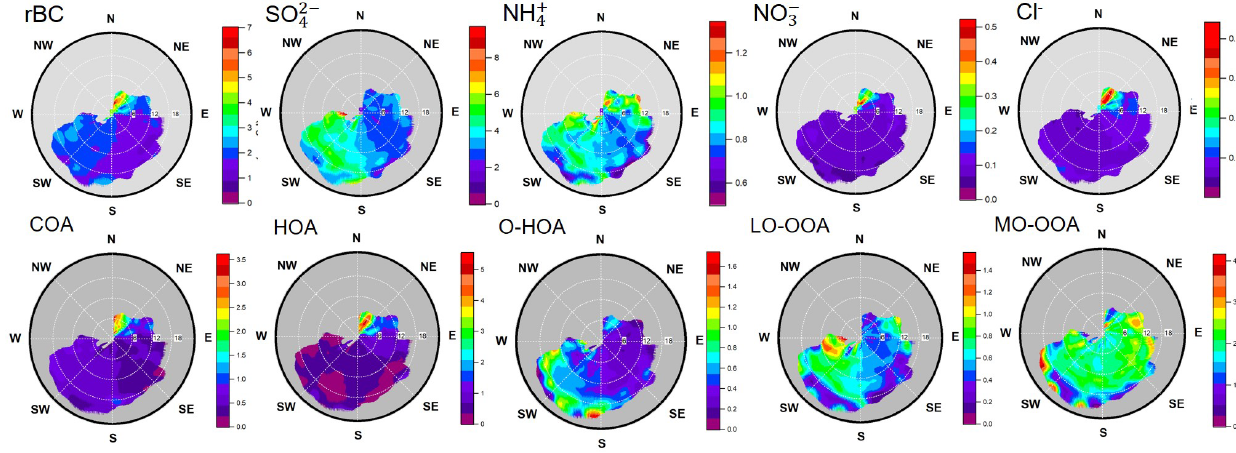
Figure 2. NWR plots of aerosol components measured by the SP-AMS during the whole campaign. (Note that all species and OA components are from laser-off measurements except for